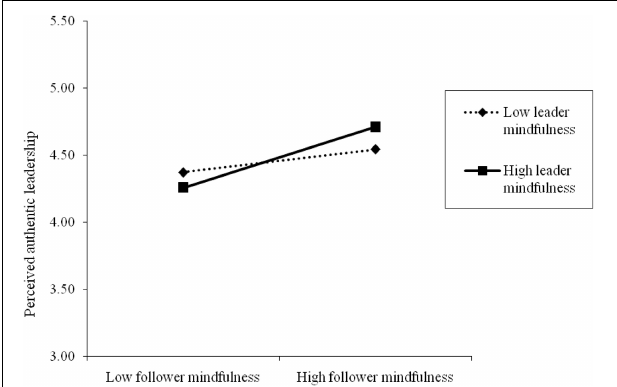
FIGURE 2 | The interaction effect of follower mindfulness and leader mindfulness on perceived authentic leadership.